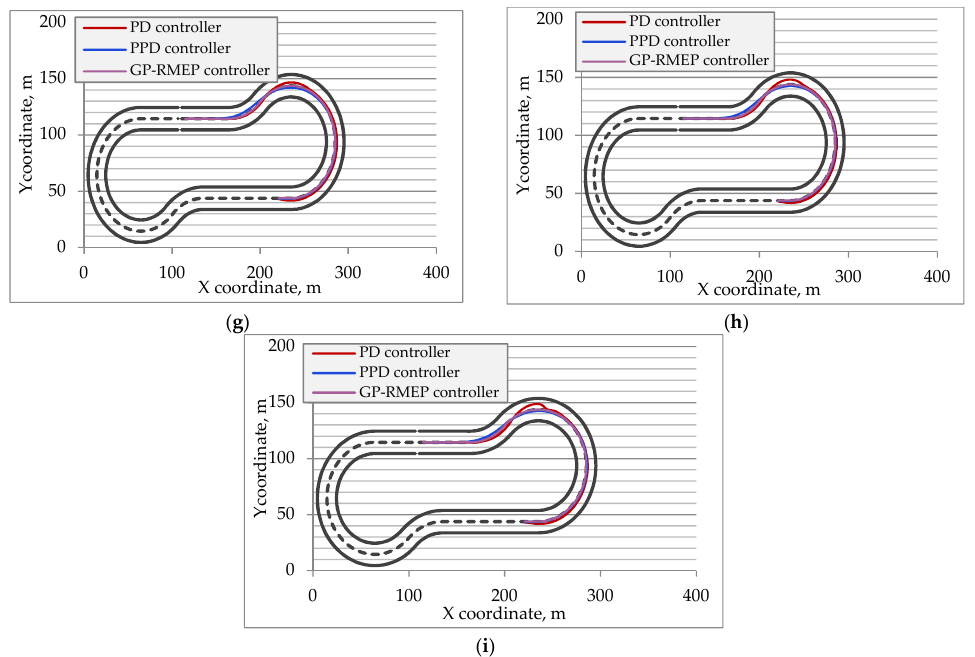
Figure 9. Car trajectories on the track tuned with prediction SAF of standard PD controller for friction coefficients. The purple curves correspond to the GP-RMEP controller, blue curves to the trajectories controlled by SAF with prediction, red curves to the original SAF. ( a ) (cid:2020) 0.5, 0.85 (cid:1848) (cid:3030)(cid:3045) ; ( b ) (cid:2020) 0.5, 0.9 (cid:1848) (cid:3030)(cid:3045) ; ( c ) (cid:2020) 0.5, 0.95 (cid:1848) (cid:3030)(cid:3045) ; ( d ) (cid:2020) 0.3, 0.85 (cid:1848) (cid:3030)(cid:3045) ; ( e ) (cid:2020) 0.3, 0.9 (cid:1848) (cid:3030)(cid:3045) ; ( f ) (cid:2020) 0.3, 0.95 (cid:1848) (cid:3030)(cid:3045) ; ( g ) (cid:2020) 0.1, 0.85 (cid:1848) (cid:3030)(cid:3045) ; ( h ) (cid:2020) 0.1, 0.9 (cid:1848) (cid:3030)(cid:3045) ; ( i ) (cid:2020) =0.1, 0.95 (cid:1848) (cid:3030)(cid:3045) .